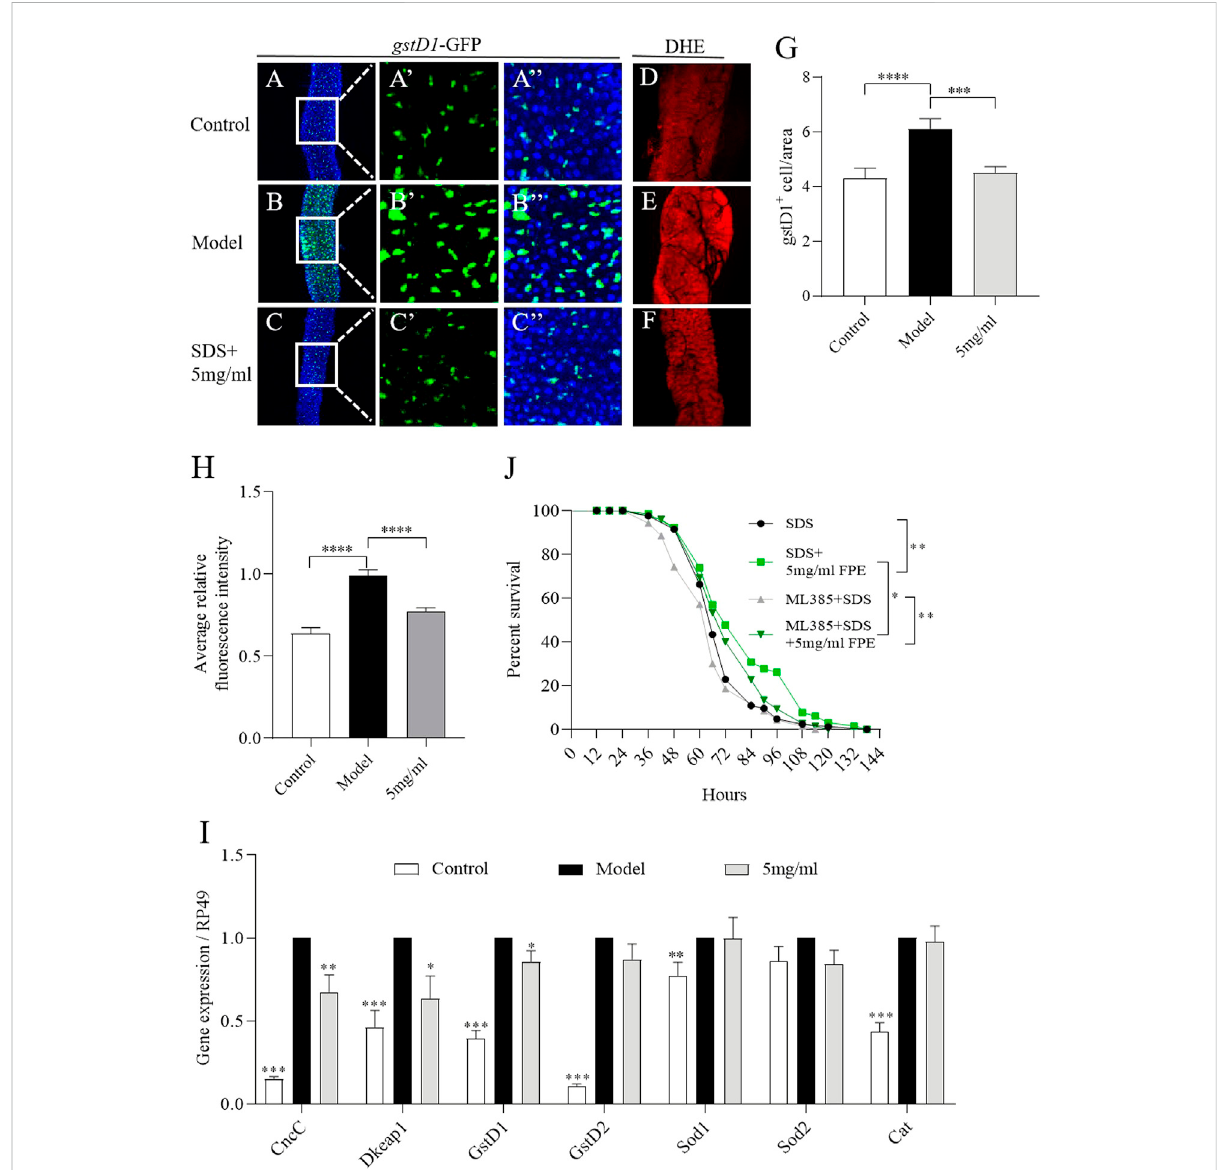
FIGURE 6 FPEdecreasesoxidativestressinducedbySDSinthegut. (A – C) Immunostainingoftheposteriormidgutofadult gstD1 -GFP fl iesthatstimulated with or without 0.6% SDS for 16 h ( n = 8 – 9). GFP staining highlighted the expression of gstD1 -GFP (green). (D – F) ROS level was monitored using DHE. (G) Quanti fi cationofthenumberof gstD1 positivecellsinthemidguts( n =16 – 17). (H) Quanti fi cationofROSlevel. (J)